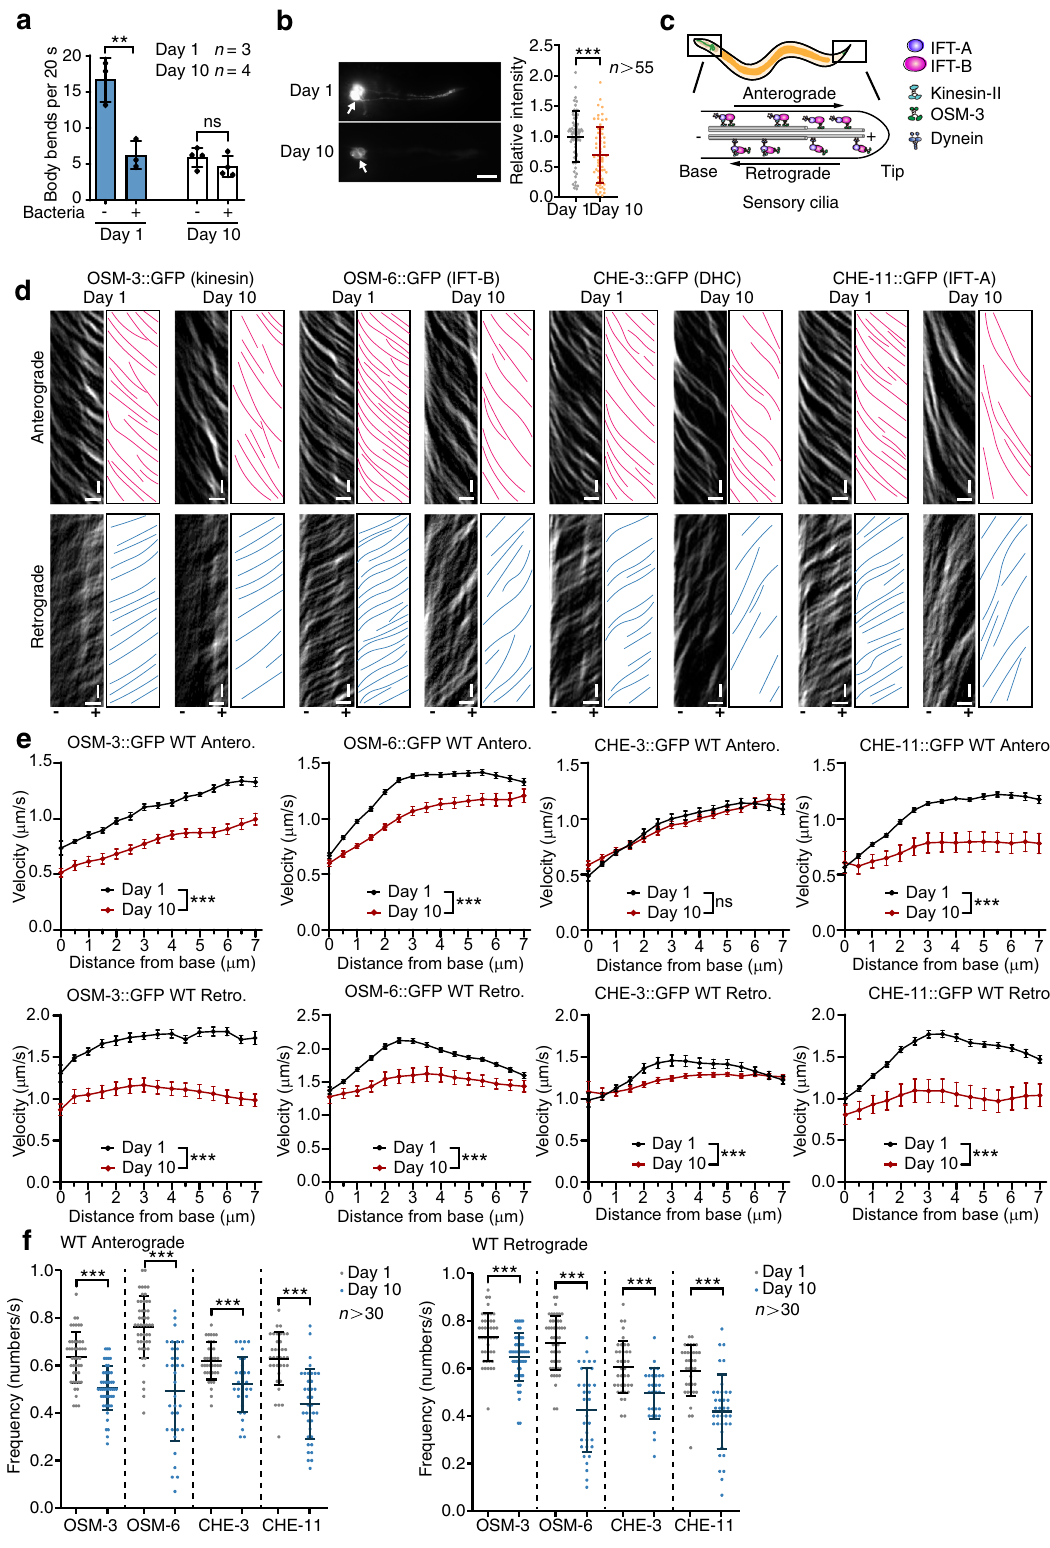
native promoter effectively ameliorated the decrease of DAF-19 in aged WT worms 22,23 (Fig. 2c). As a result, overexpressing daf-19c increased all four examined IFT proteins in the amphid/phasmid neurons soma of aged worms (Fig. 2d). In young worms, daf-19c overexpression still cause a robust increase of the examined IFT components in the soma of amphid neurons and CHE-3::GFP